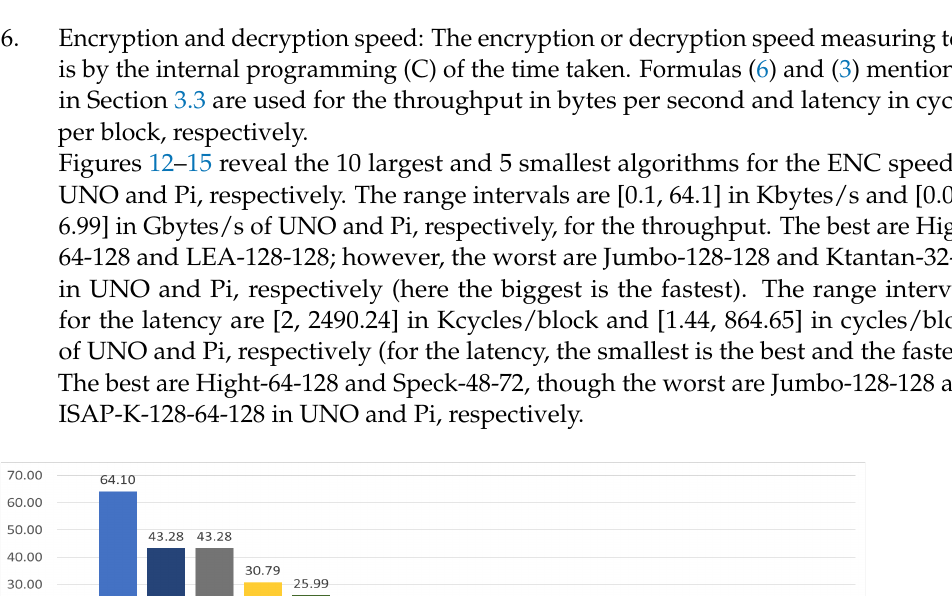
Figure 11. The 10 least speed latency in key schedule and 5 biggest in Pi.